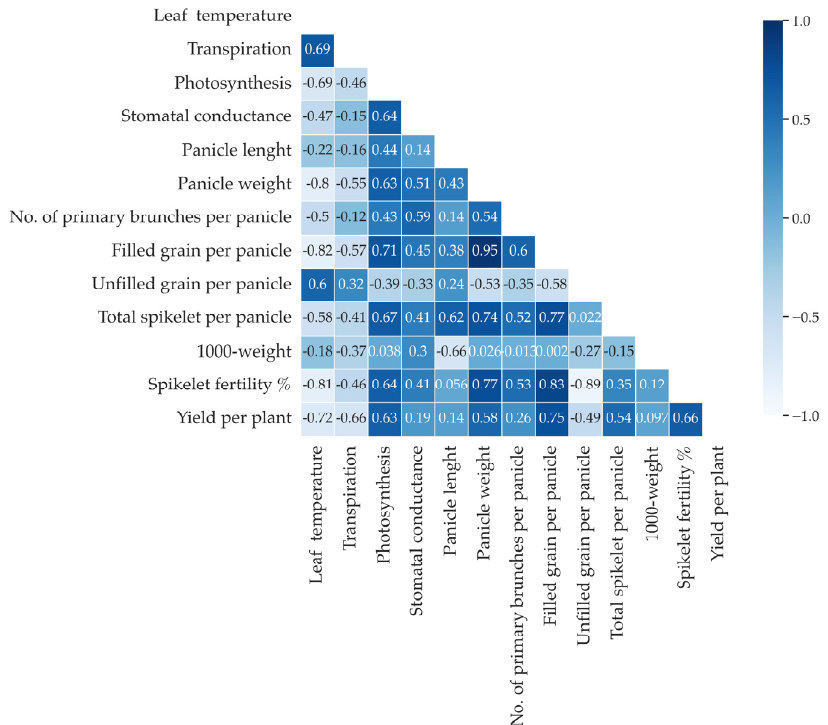
Figure 5. Correlation matrix of physiological parameters and yield components under HS, auxin application, and CK treatment conditions.